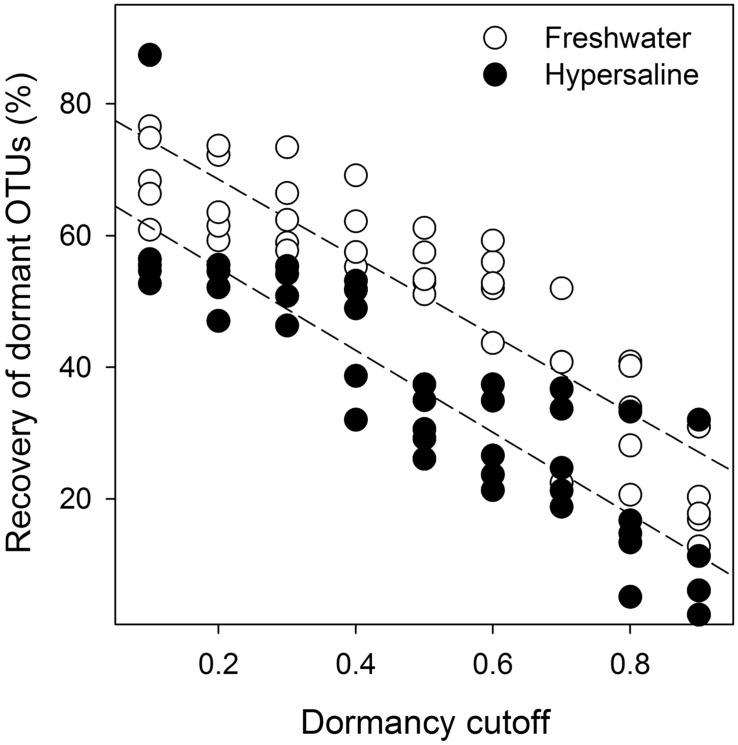
Bacterial dormancy decreased linearly as the cutoffs estimating dormancy increased or became more stringent and was more prevalent in freshwater lakes. Indicator linear regression analysis (R2 = 0.82, F86,8 = 133, P < 0.001, n = 10) was based on the relative recovery of dormant OTUs across a range of cutoffs (0.1–0.9) calculated as 1 - (rRNA recovery/rDNA recovery) for each OTU from rDNA and rRNA community libraries. Dormancy was 16% lower in hypersaline than freshwater lakes measured as the percent decrease between the significantly different y-intercepts (P < 0.001) from the equations for each lake.